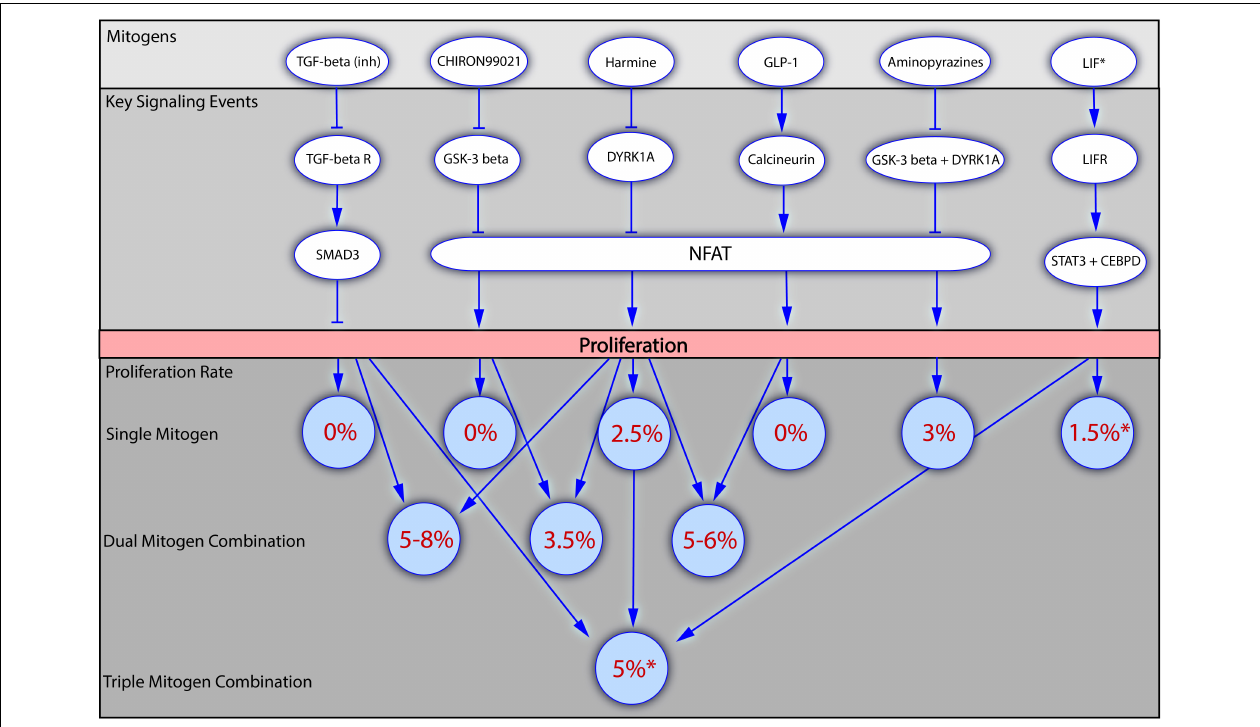
FIGURE 2 | Mitogenic synergy in human beta cell proliferation. The figure presents how application of mitogens alone or in combinations influences the beta cell proliferation. Several of the most potent mitogenic compounds are depicted in the top block, together with the key signaling events through which they regulate beta cell proliferation (the block below). The bottom block of the figure demonstrates how the values of beta cell proliferation rates increase upon the application of dual or triple mitogen combinations in comparison to the effects of the individual mitogens. Numbers in brackets indicate the literature references. *For all the mitogens, except LIF, the values of proliferation rates were obtained with the staining for Ki67 presence, and are therefore suitable for comparison. For LIF the proliferation rate has been obtained with the EdU incorporation assay. LIF is included into the scheme as the first mitogen described in a triple combination (LIF + Harmine + TGF-beta